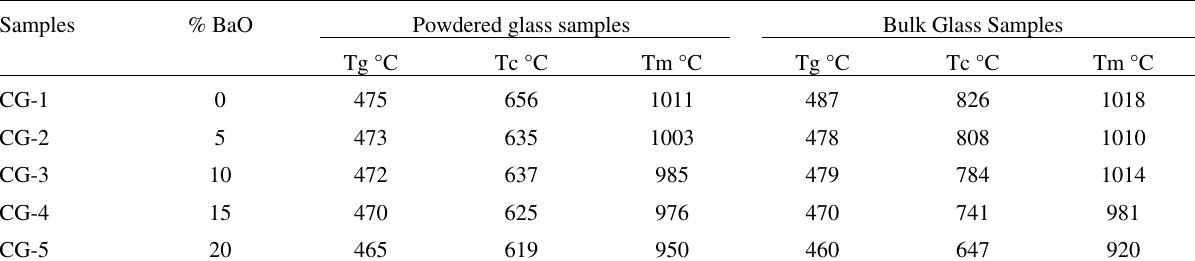
Table 1. Results obtained from DTA curves of the analyzed samples.